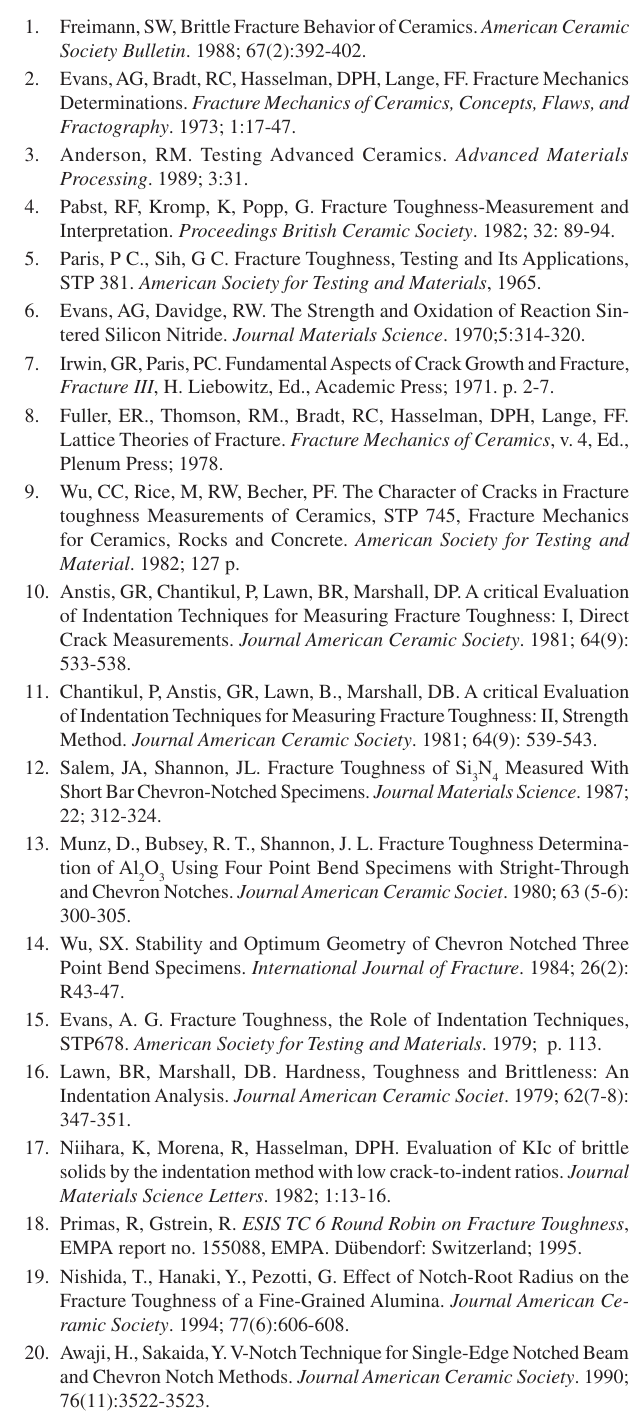
Table 3. Vickers hardness, 4-point bending strength and fracture toughness determined by the IF and SEVNB method. Sinter Condition Hardness Sample